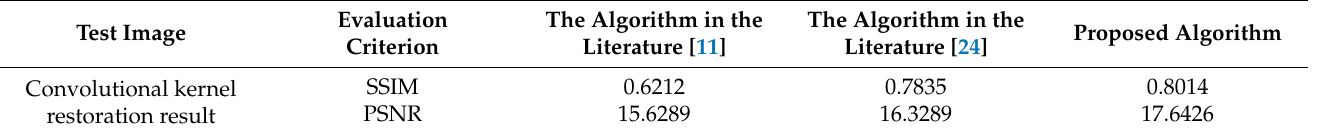
Table 2. Kernel estimation quality evaluation